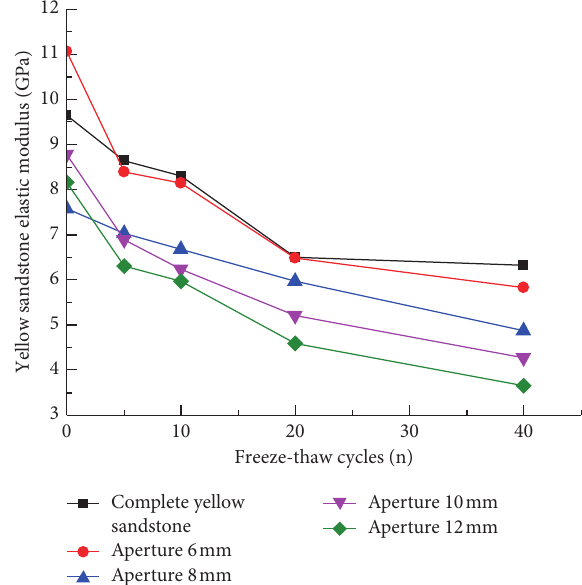
Figure 5: Elastic modulus curve of yellow sandstone under freeze-thaw